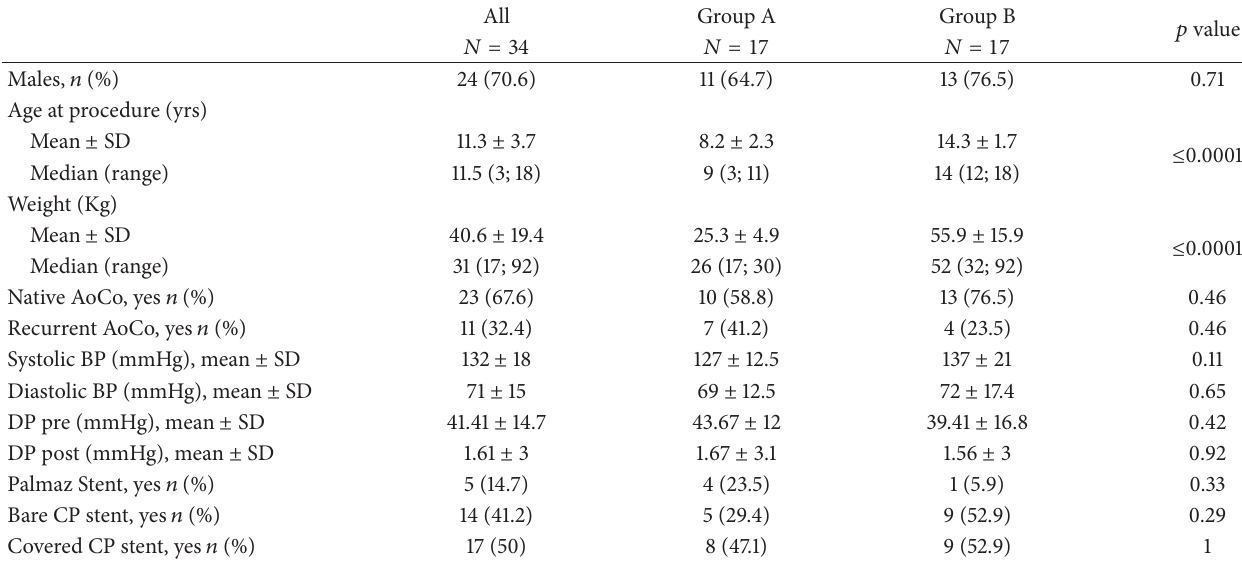
Table 1: Main characteristics of enrolled